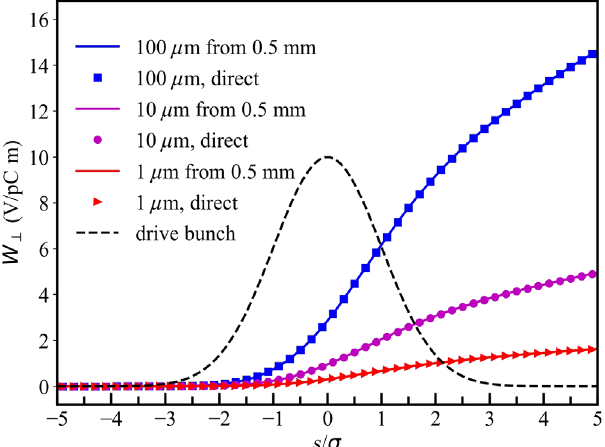
FIG. 6. Comparison of the reconstructed transverse wake potentials (solid lines) with direct ECHO simulations (symbols) performed at several rms bunch lengths, as indicated in the legend.